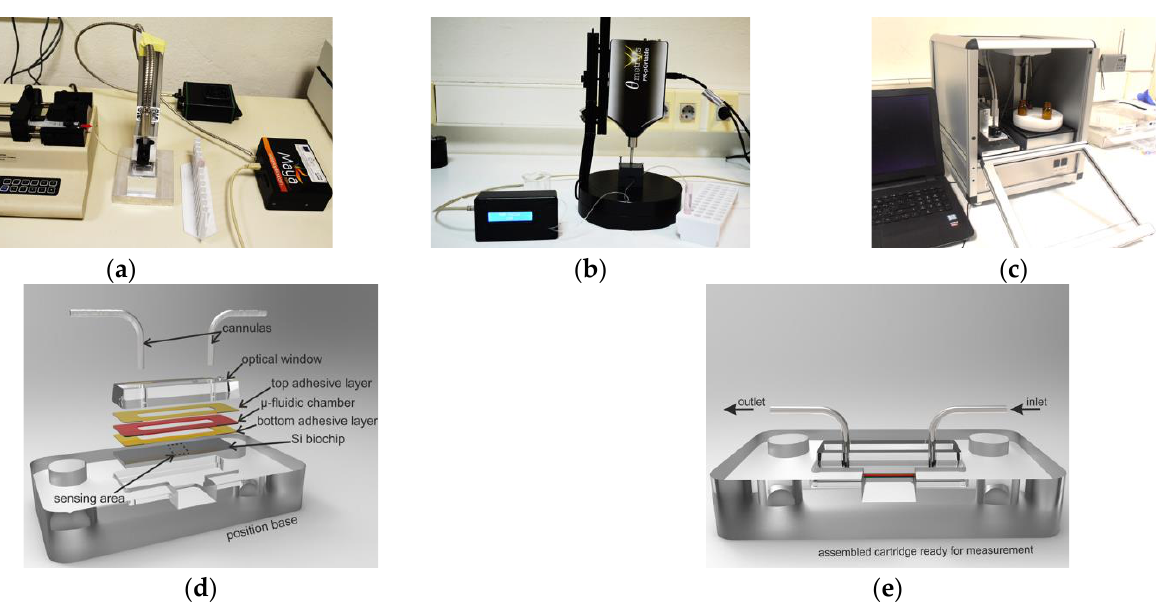
Figure 2. ( a – c ) WLRS instrumentation formats that have been developed over the years, starting from an off-the-shelf format ( a ) to more integrated ones ( b,c ). ( d ) Main parts of the microfluidic module. ( e ) Chip assembled with the microfluidic module and placed on the docking station.